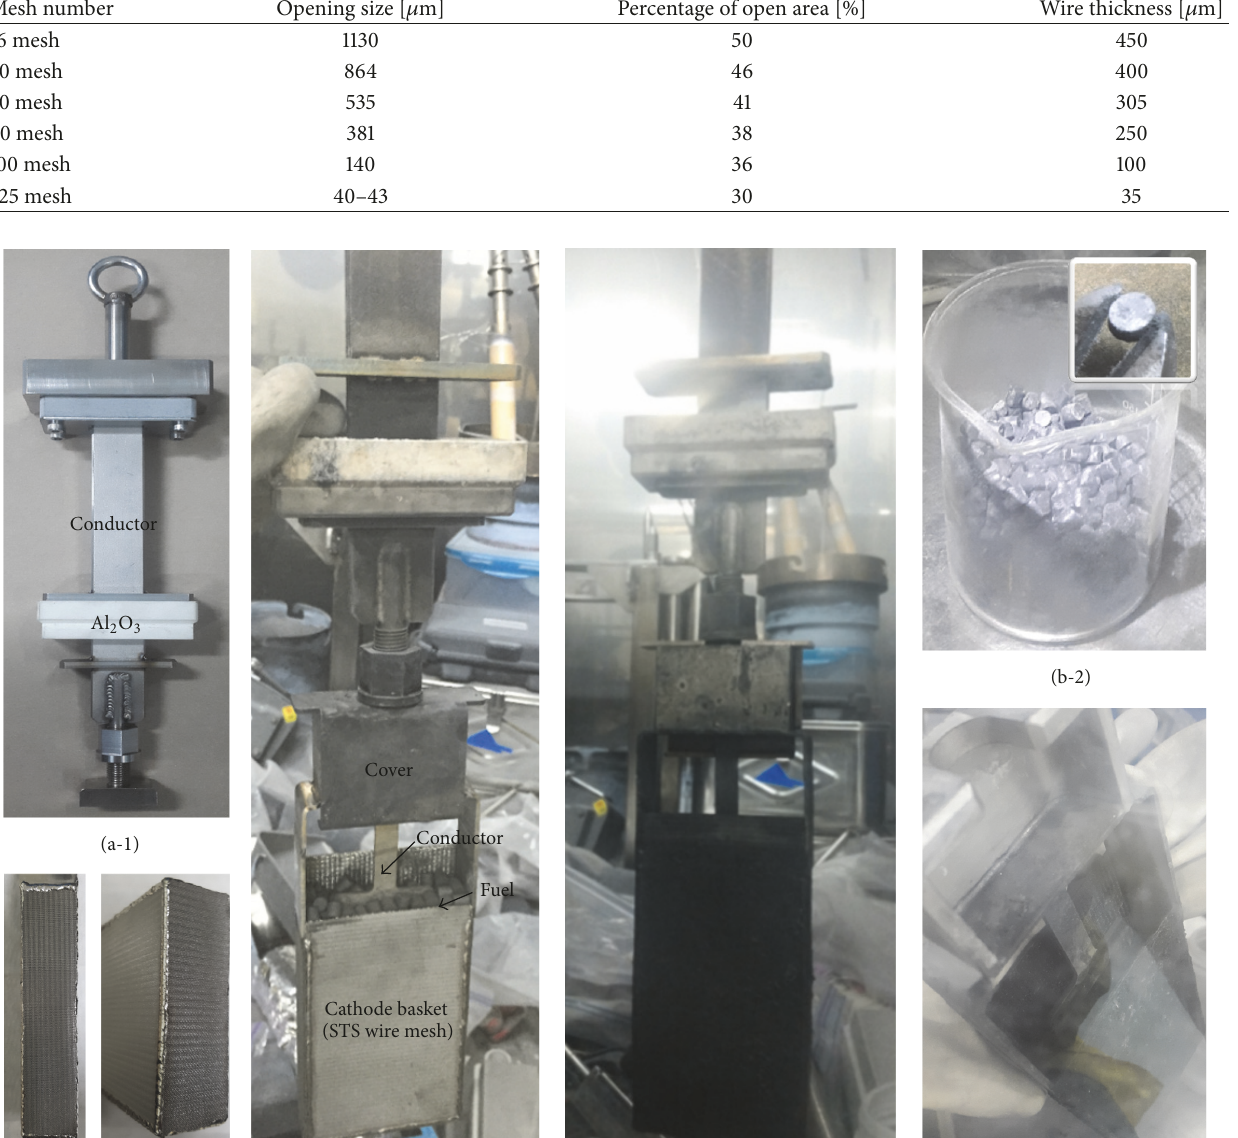
Table 1: Specifications of various STS wire meshes in the cathode basket used in this study.